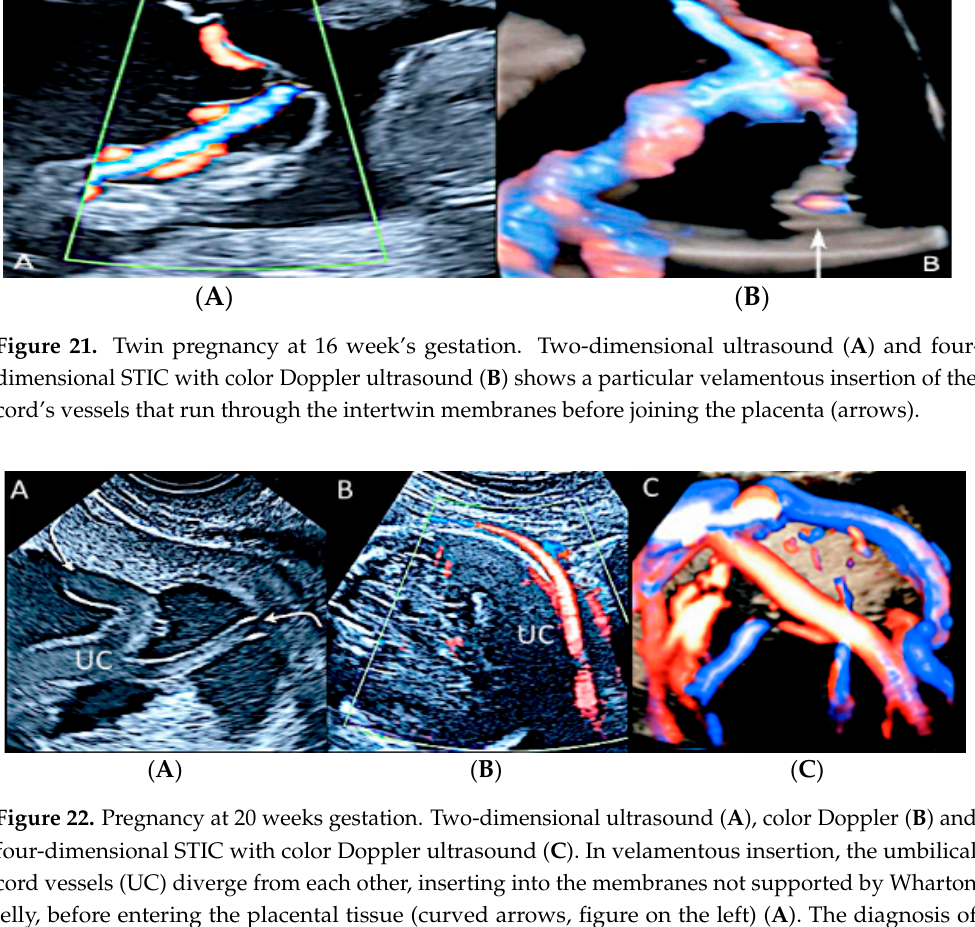
Figure 20. Velamentous cord insertion into the placental membranes ( A ) with direction of blood flow indicated by curved arrows and pathologic correlation (arrows) ( B ) .